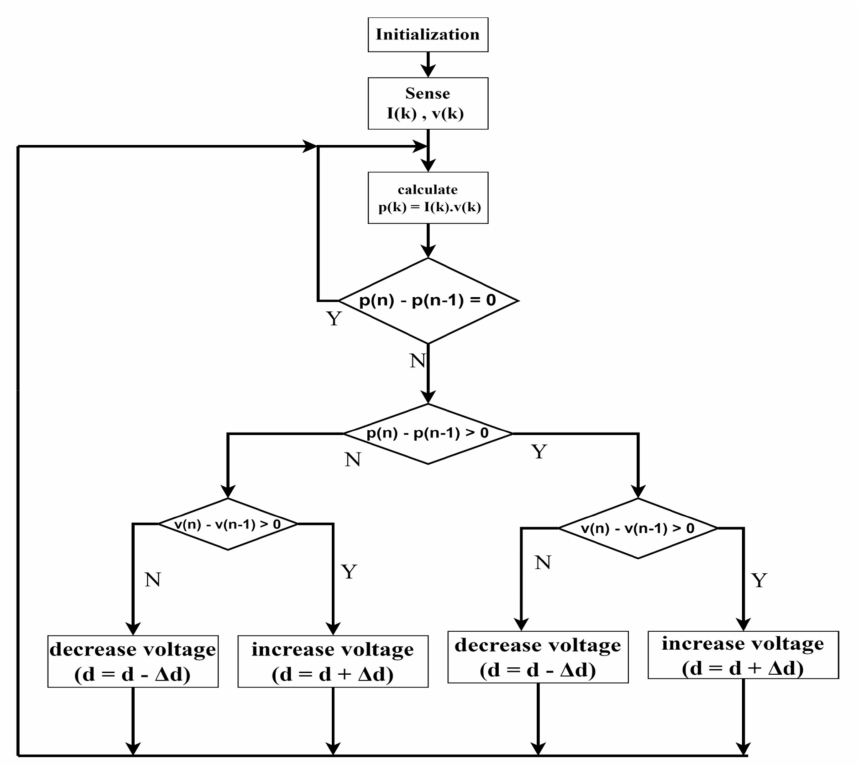
Figure 7. Flowchart for P&O algorithm.